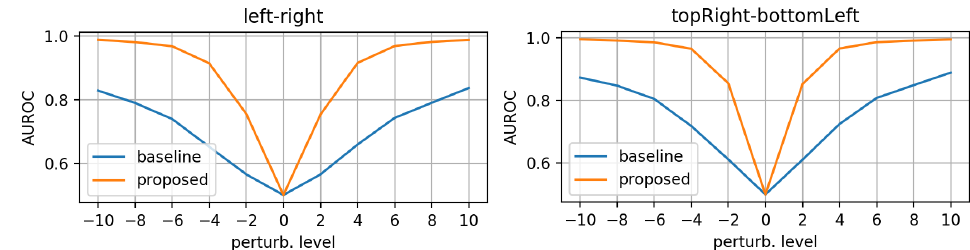
Figure 6. AuRoC performance for the baseline and proposed architecture when tested against mask translation in various directions. Training done only on original data.